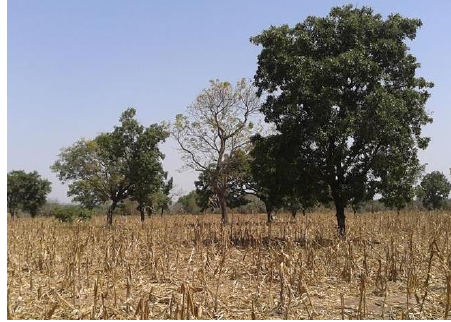
Figure 6. Harvested crop intermixed with trees in the study